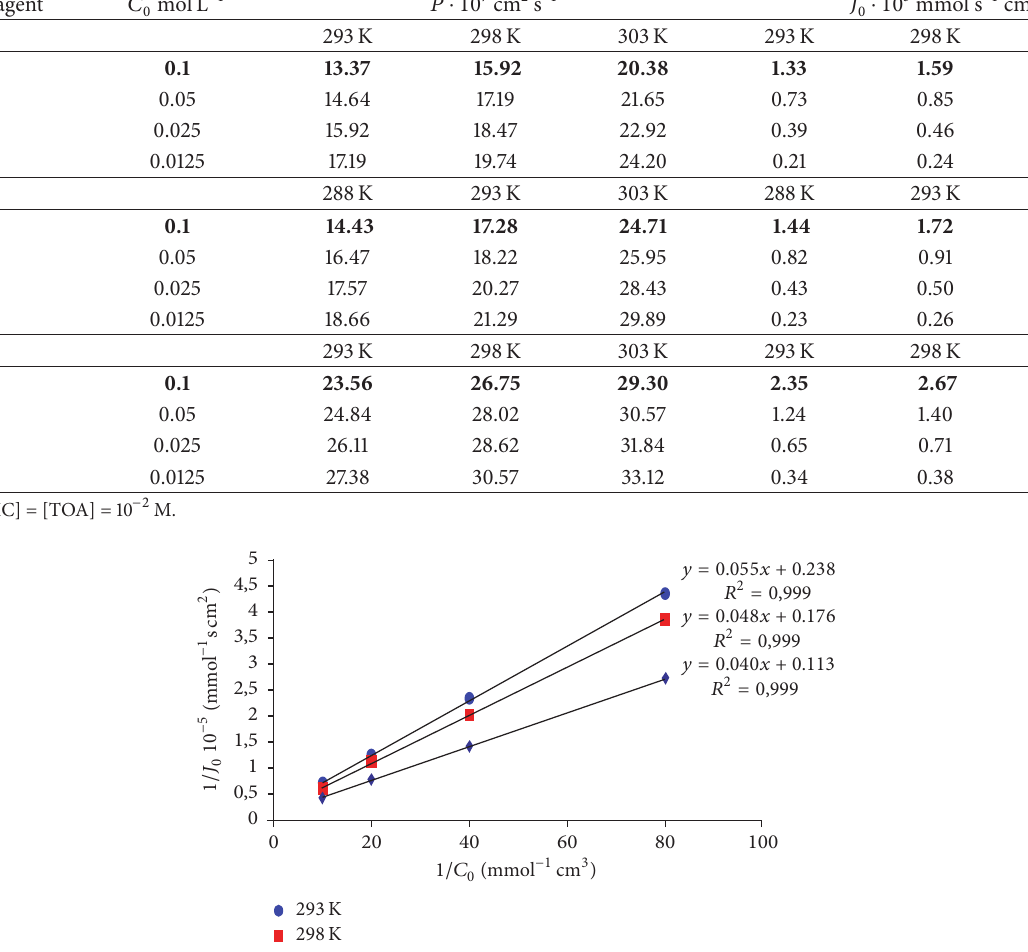
Table 4: Temperature factor influence on the evolution of macroscopic parameters 𝑃 and 𝐽 0 . Extractive agent